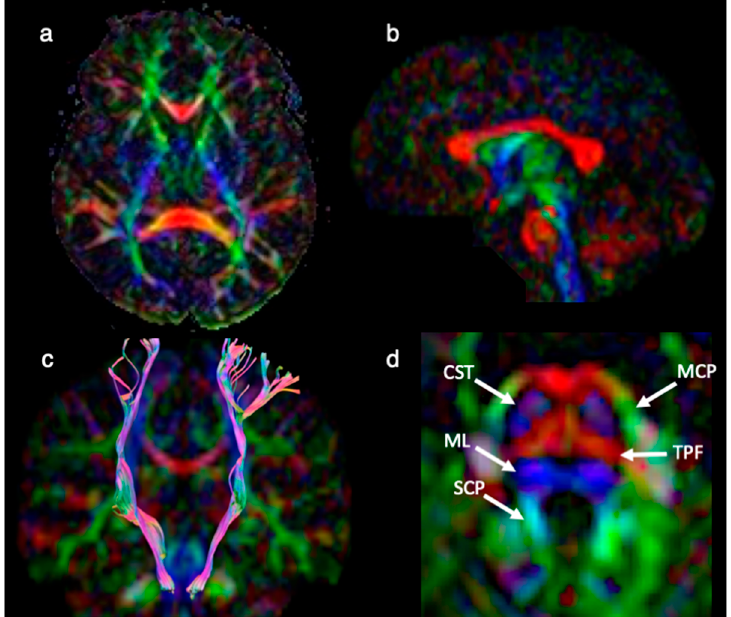
Figure 4. DTI obtained at 8 years of age. Axial ( a ), and sagittal ( b ) color-coded fractional anisotropy (FA) map showing qualitative normal white matter organization of the brain. Coronal fiber tractogra- phy superimposed on color-coded FA map ( c ) displays the normal course of the corticospinal tracts (CST) on both sides. Axial color-coded FA map at the level of the middle pons (close up, ( d )). The principal diffusion direction within the areas of high degree anisotropic diffusion is color-coded in red (left to right diffusion), blue (superior-inferior diffusion) and green (anterior-posterior diffusion). At the level of the middle pons ( d ), the CST (anteriorly) and the medial lemniscus (ML) (posteriorly) can be appreciated as blue vertical structures. Between the CST and ML, the transverse pontine fibers (TPF) can be seen as a red structure. The medial cerebellar peduncle (MCP) can be detected as a green structure laterally to the brainstem. The superior cerebellar peduncle (SCP) is shown as a light blue-green structure (due to a slightly vertical orientation) medially to the